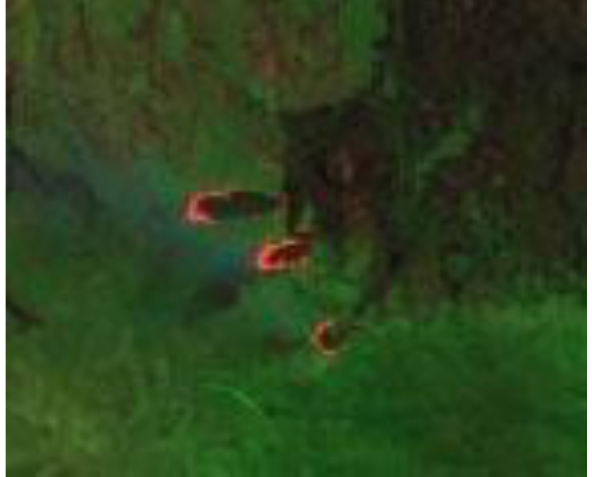
Figure 6. Real-time Landsat 8 image (band combination 7-5-3)